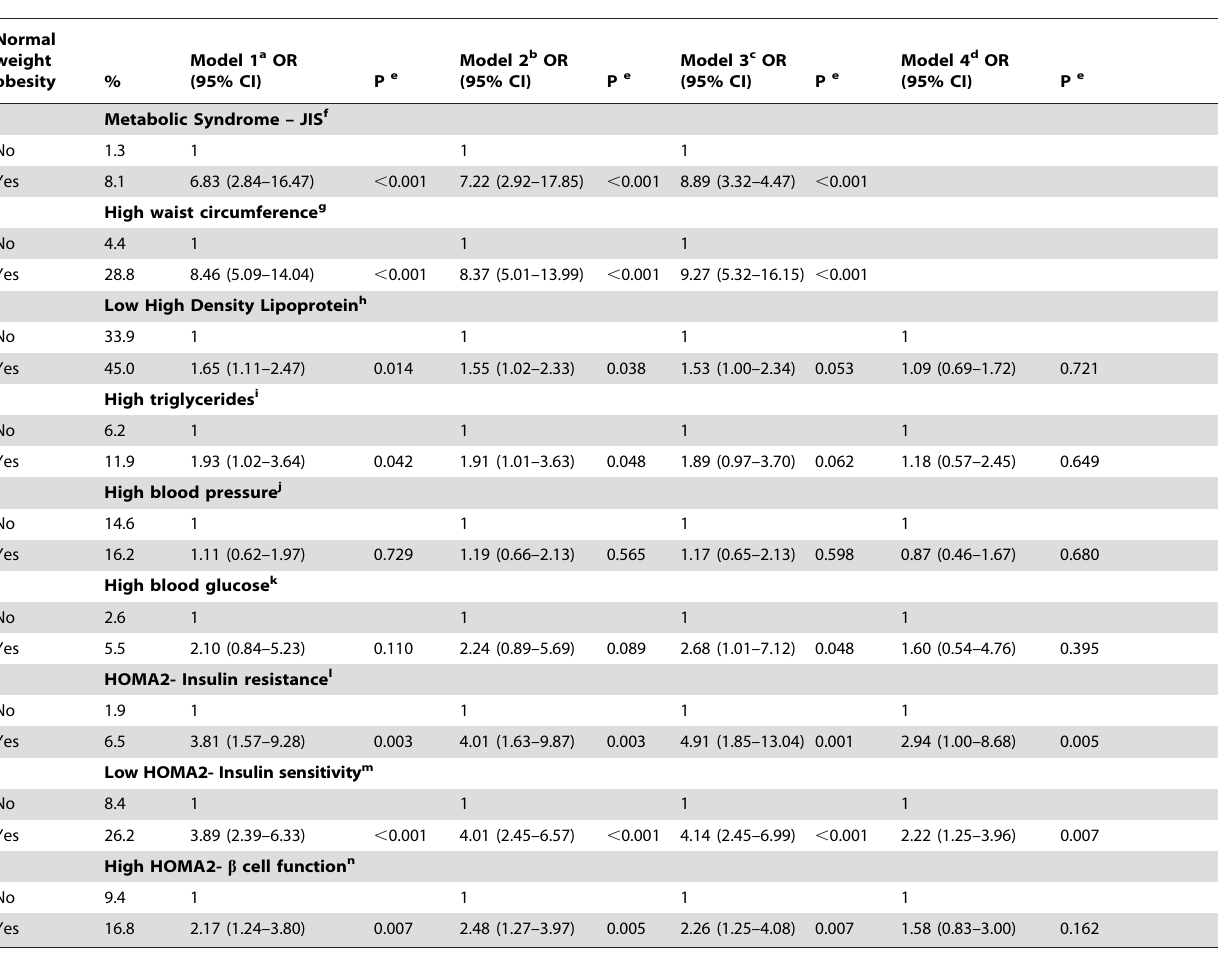
Table 5. Associations between normal weight obesity defined as the sum of the triceps and subscapular skinfolds . 90 th percentile with metabolic syndrome and its components and insulin resistance, insulin sensitivity and b cell function, 1978/79 Ribeira˜o Preto birth